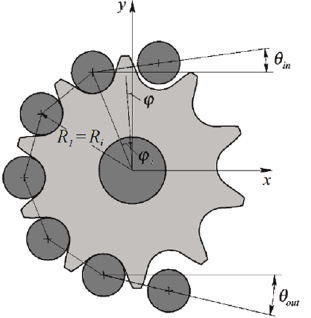
Fig. 1. Sprocket in an arbitrary load position